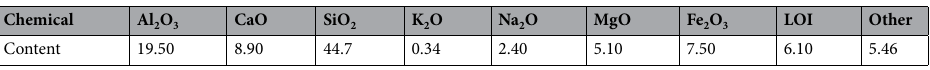
Table 1. Chemical composition of coconut shell ash